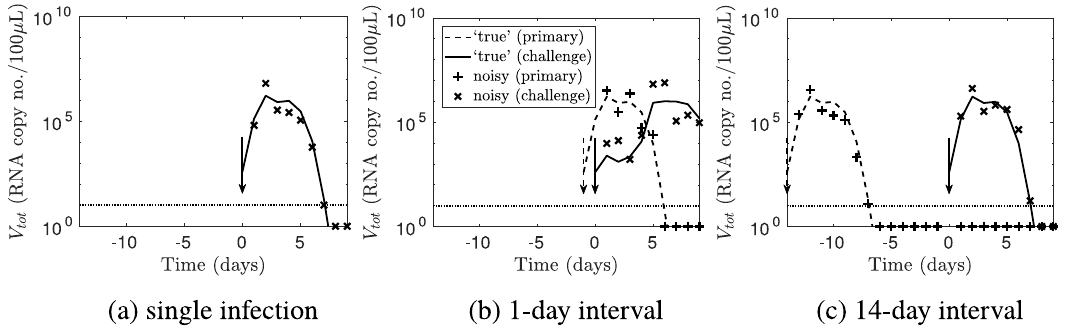
Fig 1. A subset of the synthetic data. (a) The line shows the simulated ‘true’ viral load for a single infection, with the arrow showing the time of exposure. The simulated viral load with noise is shown as crosses. The horizontal line indicates the observation threshold (10 RNA copy no./100 μ L); observations below this threshold are plotted below this line. Values below the observation threshold were treated as censored. (b—c) For sequential infections with the labelled inter-exposure interval, the dashed and dotted lines show the simulated ‘true’ viral load for a primary and challenge infection respectively; the arrows show the times of the primary and challenge exposures. The simulated viral load with noise is shown as